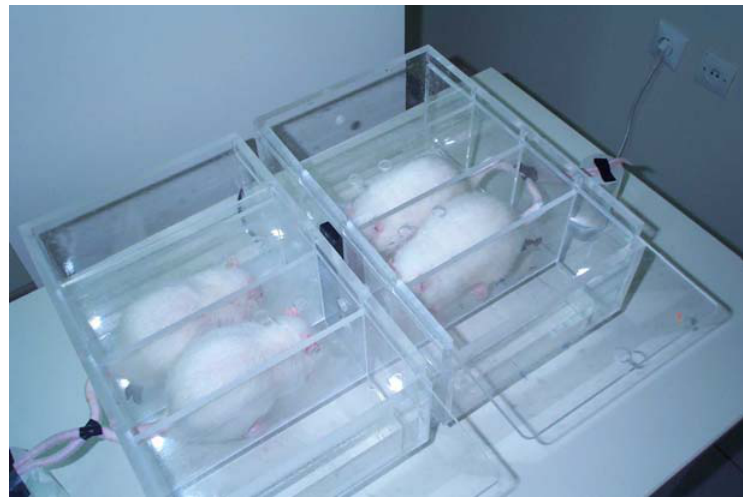
FIGURE 1 . Plexiglas cages and animal arrangement around the